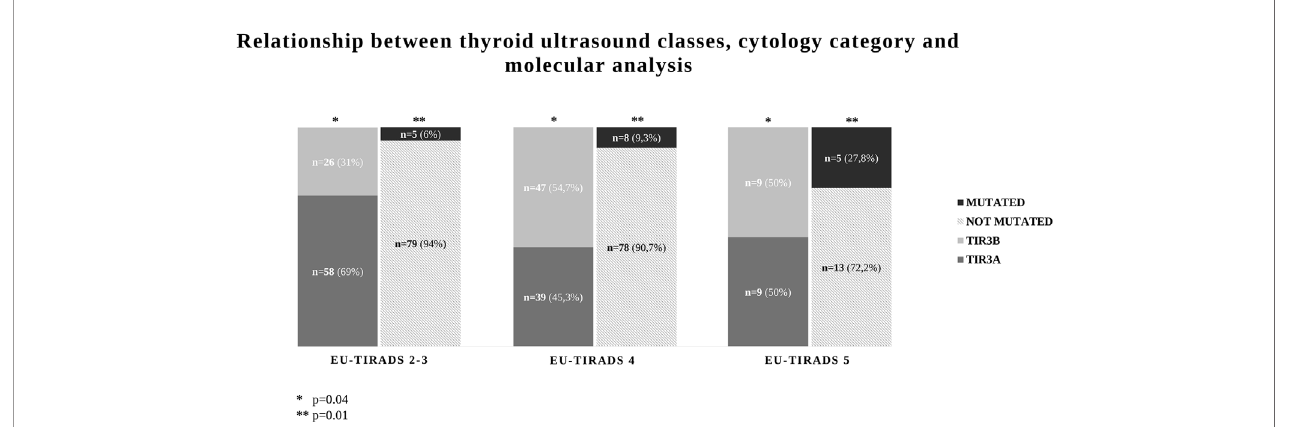
FIGURE 1 | Relationship between thyroid ultrasound and cytological categories and seven-gene panel results in 188 indeterminate thyroid nodules (TIR3).